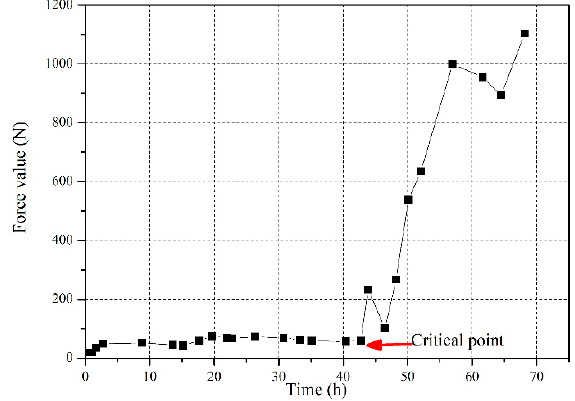
Figure 10. Fracture appearance of remains on the bottom steel plate.